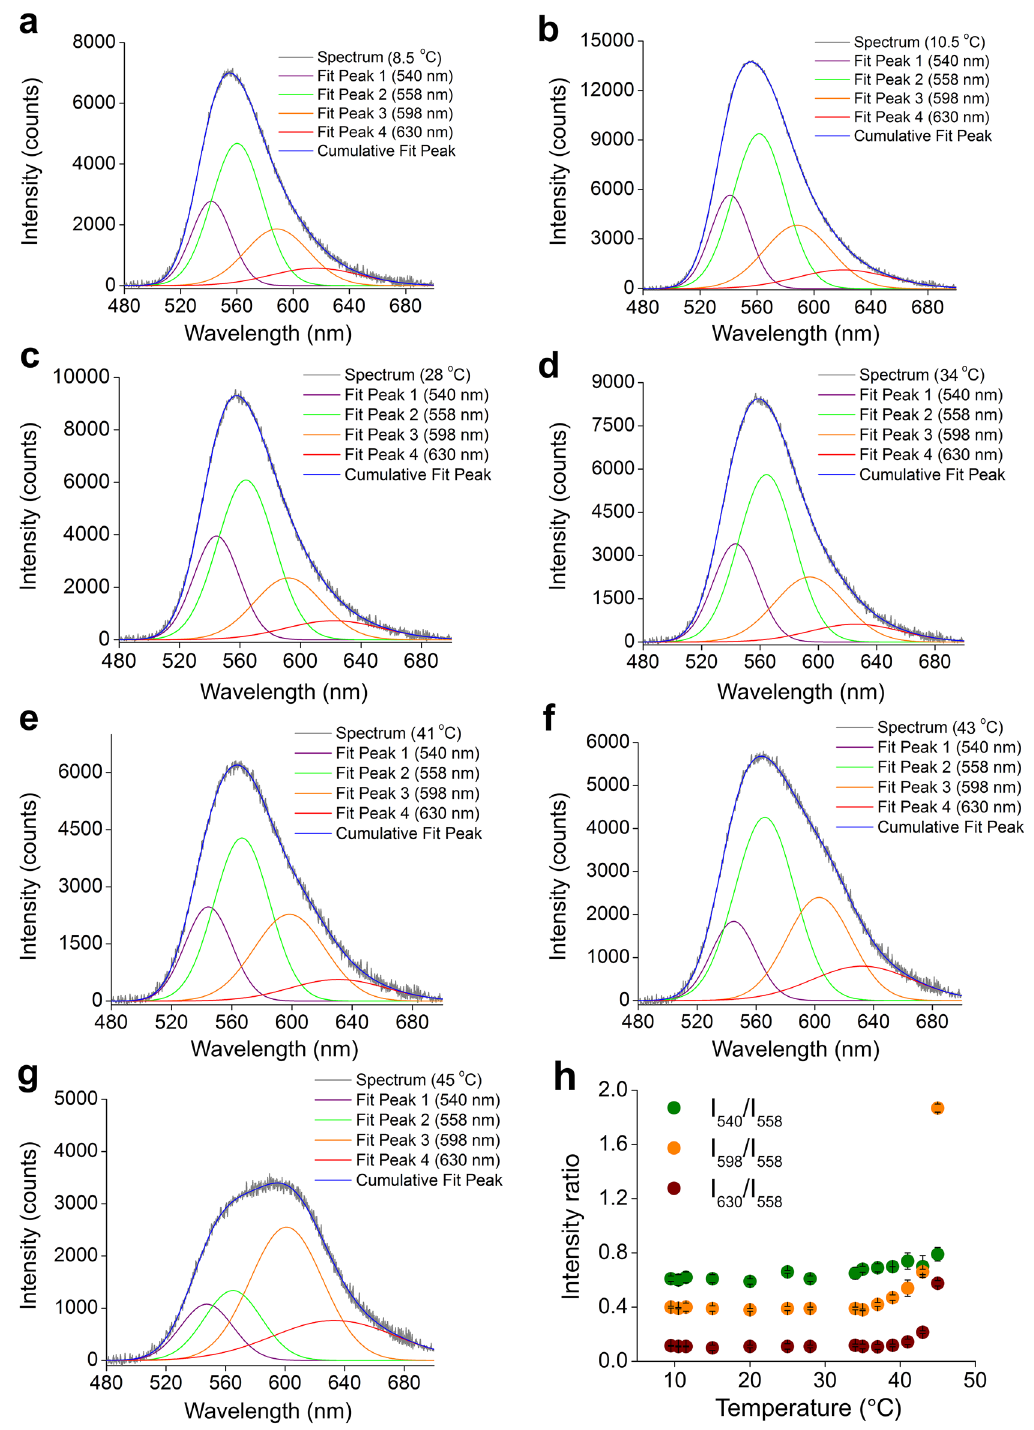
Figure 3. Gaussian fits peaking at 540 nm, 558 nm, 598 nm and 630 nm along with the experimental spectra. ( a – g ) Fitted spectra at various high temperatures. At 8.5, 10.5, 28, 34, 41 and 43 ºC, the 558 nm green component is more intense than the other three components. At 45 ºC, the orange component is the most intense one. ( h ) Variation of the measured intensity ratio I 540 /I 558 (mean ± SD) , I 598 /I 558 (mean ± SD) and I 630 /I 558 (mean ± SD) of the Gaussian components with temperature. The intensity ratios I 598 /I 558 and I 630 /I 558 increase exponentially as the temperature is increased from 28 ºC to the maximum of 45 ºC, while the change in I 540 /I 558 is linear. At low temperatures, the spectra do not show any significant change in the ratios, except in I 540 /I 558